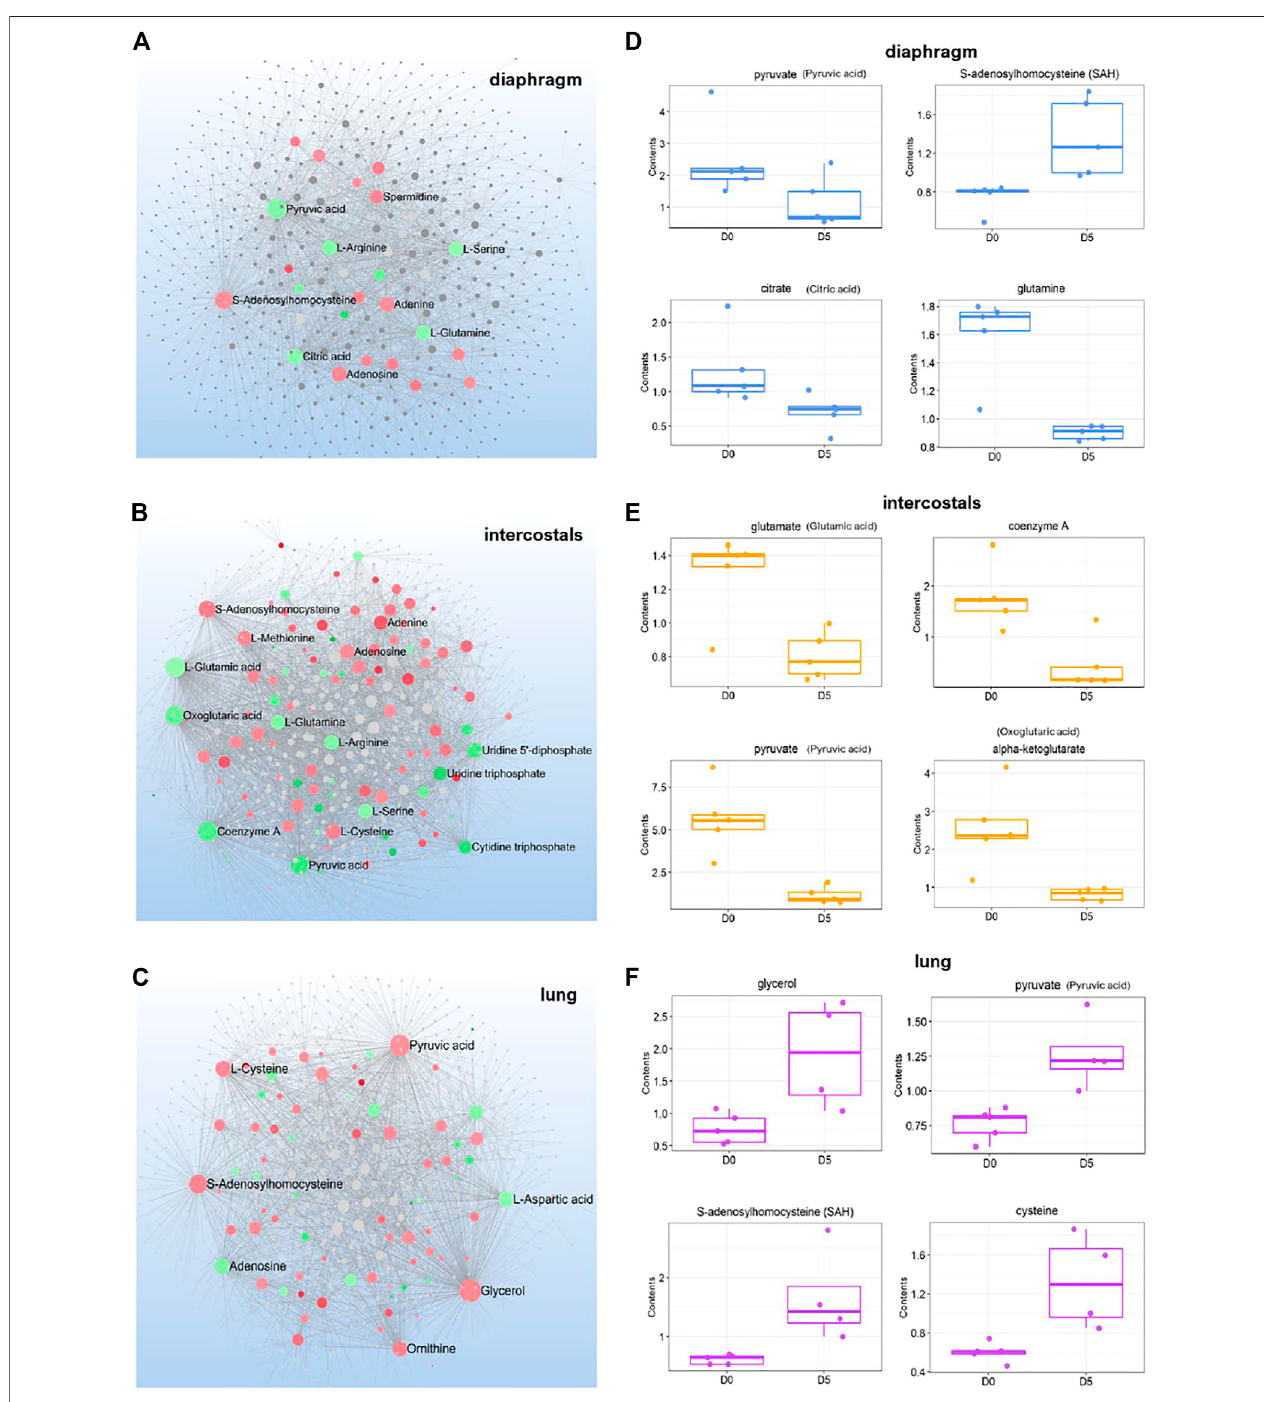
FIGURE 3 | Metabolite-metabolite interactions network of differential metabolites (A-C) and boxplot for the 4 top-ranked metabolite hubs (D-F) in diaphragm, intercostals, and lung tissue. Metabolite hubs in the network are highlighted in colors, where green color indicates the downregulation and red color indicates the upregulation. Dot size represents the betweenness/association among metabolites.